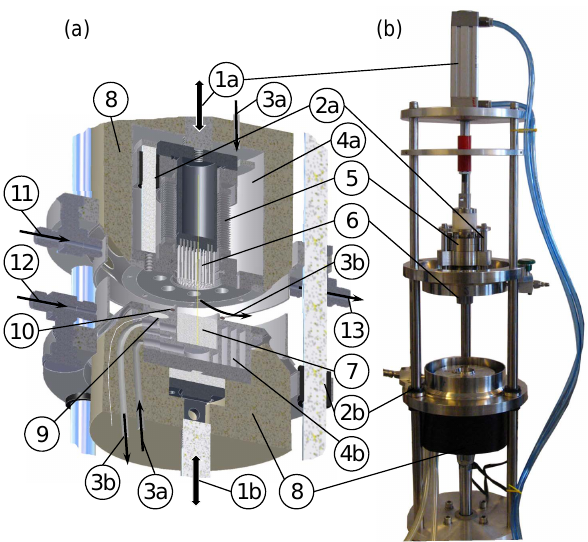
Figure 1. (a) Schematic of the CIC needle cracker (NC) dry ex- traction unit and (b) picture with cooling jacket and insulation dis- mounted at the top part. Pneumatic actuators (1a, 1b), guiding SS rods with bearings (2a, 2b), cold air inlet and outlet for cooling (3a and 3b respectively), cooling jacket and cooling cavities (4a and 4b, respectively), SS welded bellow (5), SS needle pins (6), ice sample (7), insulation (8), temperature sensor (9), indium wire for vacuum seal (10), gas inlets (11, 12) and outlet (13) equipped with valves.